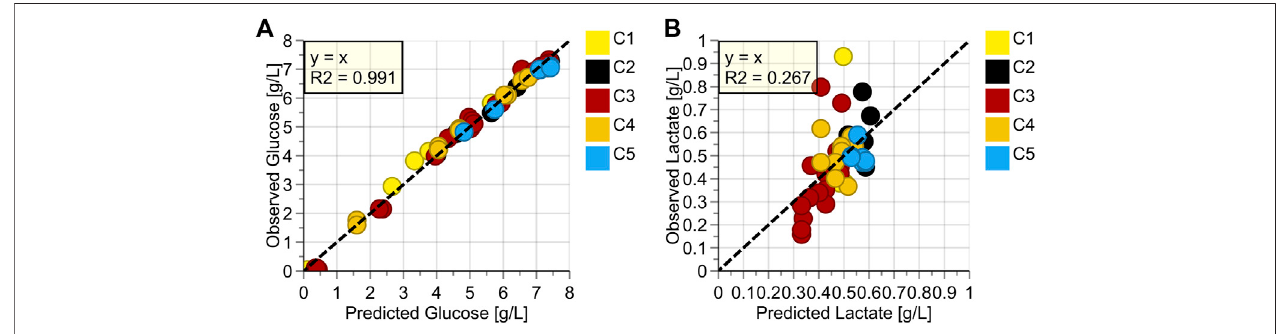
FIGURE 4 | Observed vs. Predicted Plots for (A) Glucose (g/L), (B) Lactate (g/L); Colored according to Batch